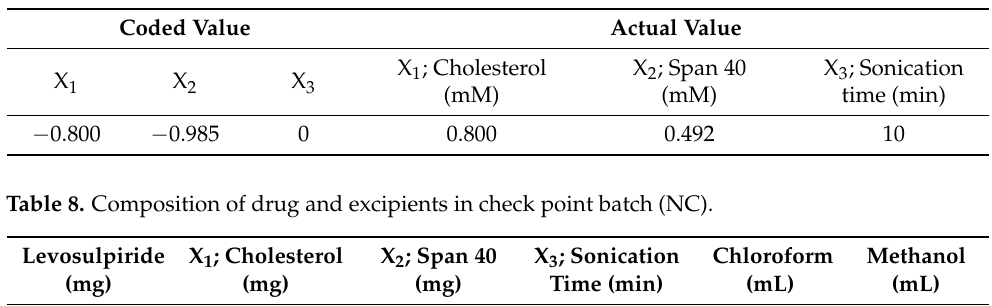
Table 7. Formulation layout for check point batch (NC).